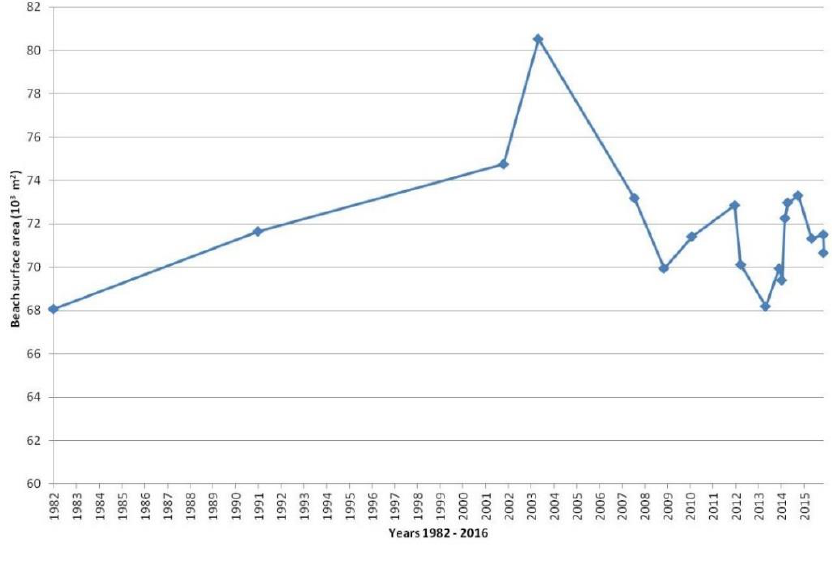
Figure 5. Beach surface evolution (1982–2016).